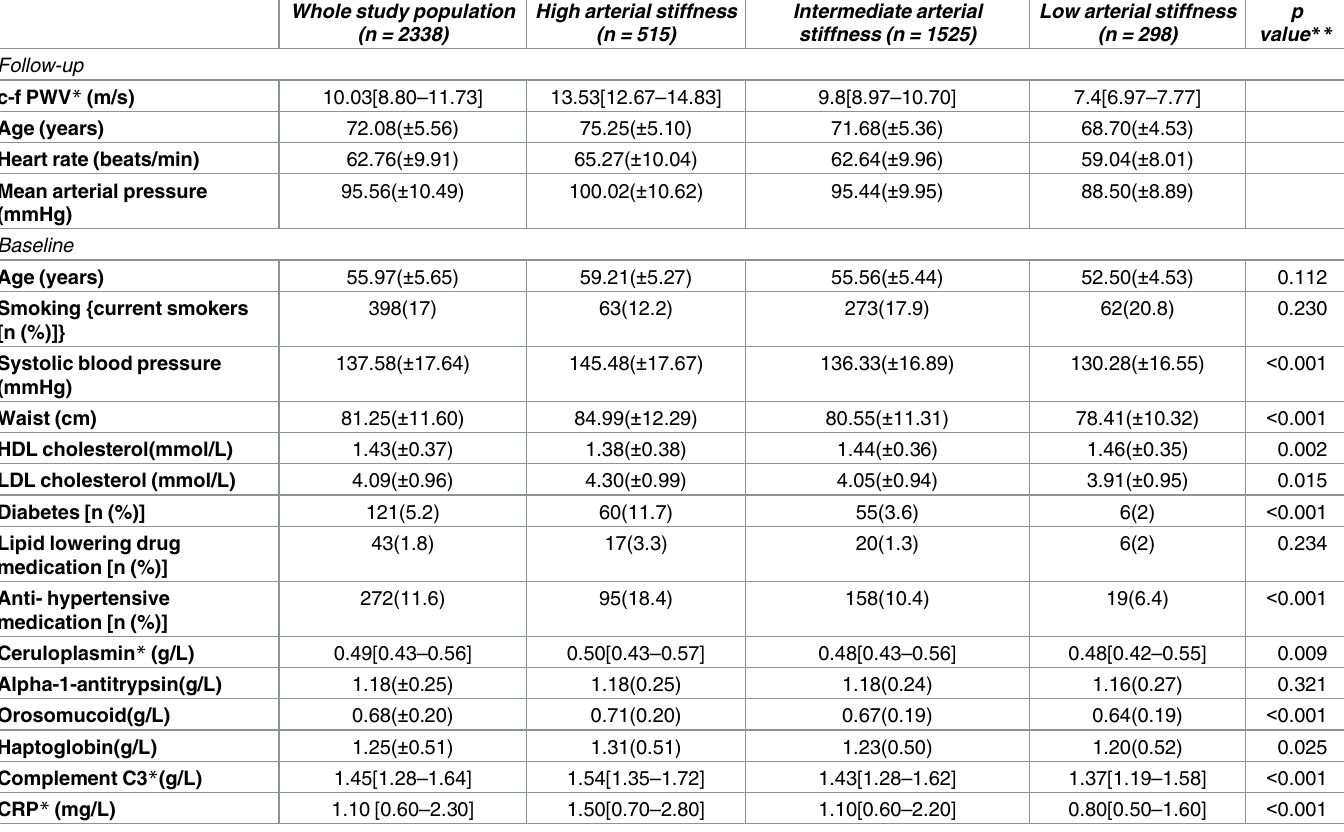
Table 1. Follow-up and baseline characteristics of the whole study population (n = 2338) and comparisons of characteristics of participants with high, intermediate and low arterial